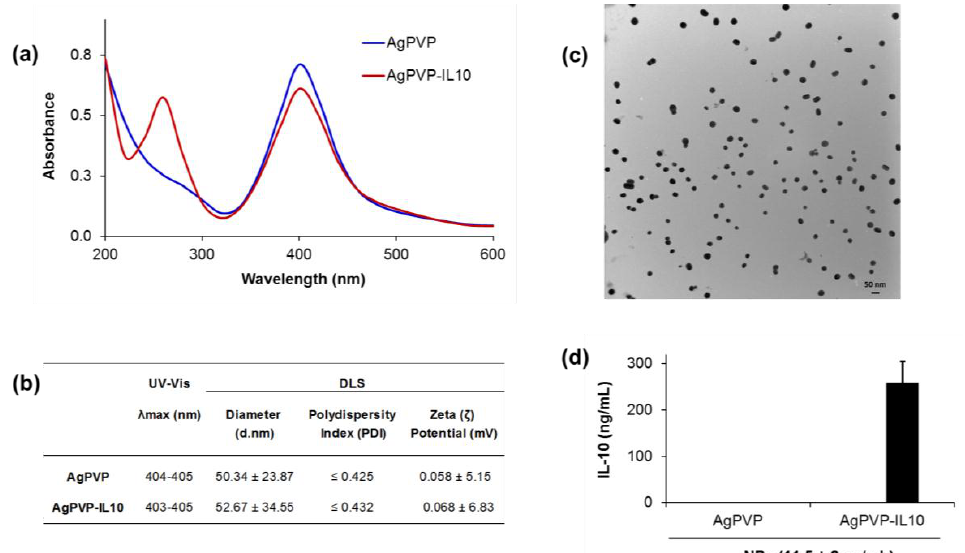
Figure 3. Characterization of IL10-conjugated Ag-PVPs. ( a ) UV-Vis spectra of rmIL-10 conjugated Ag-PVPs showing changes in absorption and an additional protein peak in the 280 nm region; ( b ) DLS characterization of Ag-PVPs before and after conjugation with rmIL10; ( c ) TEM image of dispersed rmIL-10 conjugated Ag-PVPs in aqueous solution (diameter size ~50 nm); ( d ) Enzyme-linked immunosorbent assay (ELISA) measurement of the amount of bioactive rmIL-10 conjugated to Ag-PVPs. The nanoparticle samples were analyzed immediately prior to use (after a week of storage). The data presented in ( a ) and ( b ) and are representative of one batch of nanoparticles, whereas the data presented in ( c ) and ( d ) are means and standard deviations of three independent samples run each in triplicate.